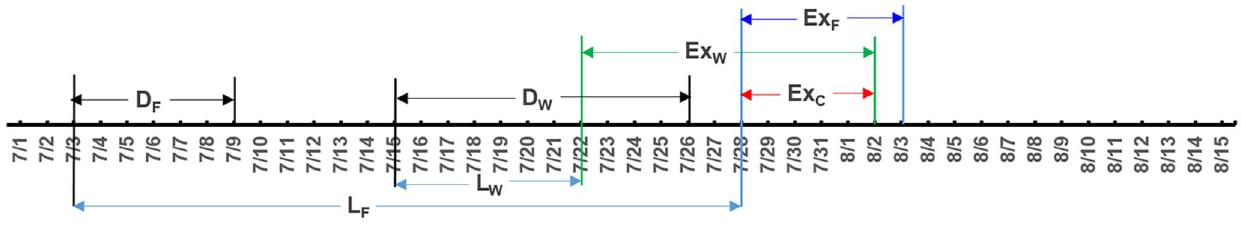
Figure 5. A timeline of exploring for duration of the effect-period. D F : duration of flooding; D W : duration of waterlogging; L F : lag time of flooding; L W : lag time of waterlogging; Ex F : the exposure effect-period for flooding alone; Exw: the exposure effect-period for waterlogging alone; Ex C : the common exposure effect-period for both flooding and